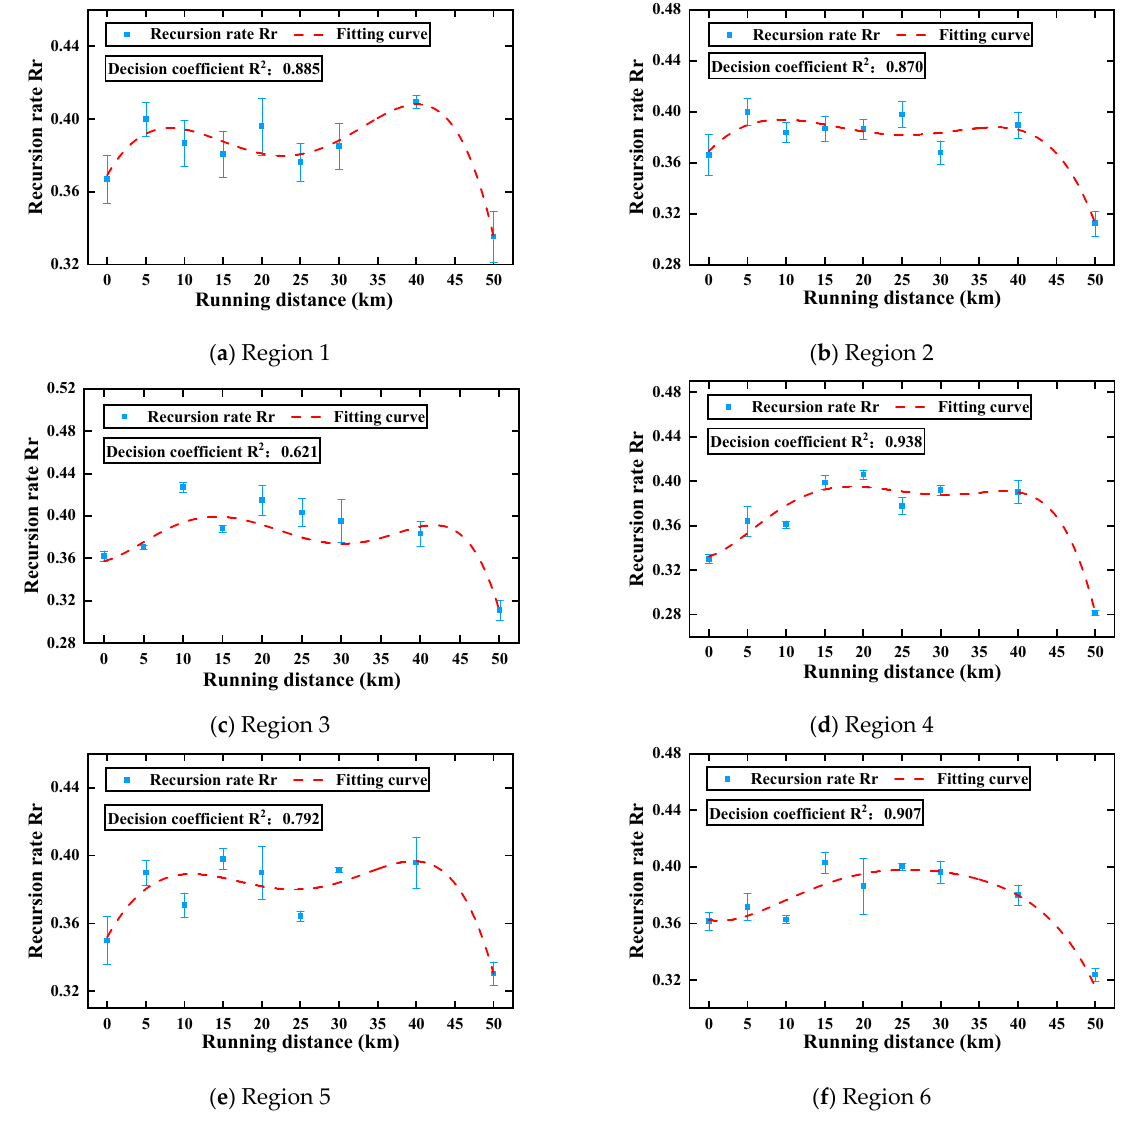
Figure 14. Evolution of recursion rate during wear. ( a ) Region 1, ( b ) Region 2, ( c ) Region 3, ( d ) Region 4, ( e ) Region 5, ( f ) Region 6.